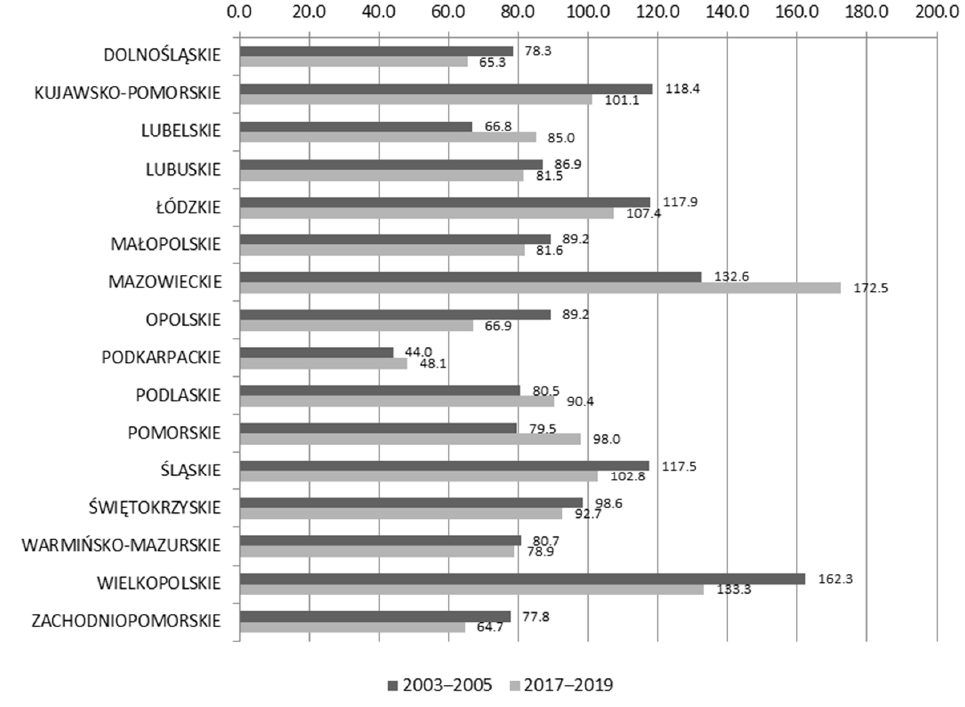
Figure 1. Distribution dynamics of the gross value added per person working in relation to the country (%). (Own study, based on the Local Data Bank).